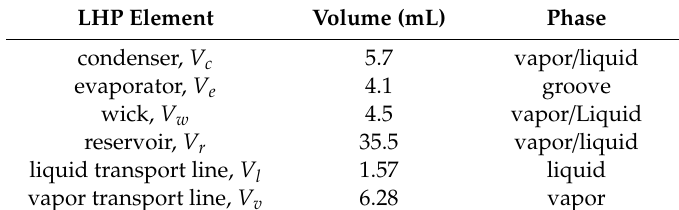
Table 1. Internal volumes of loop heat pipe (LHP) elements.